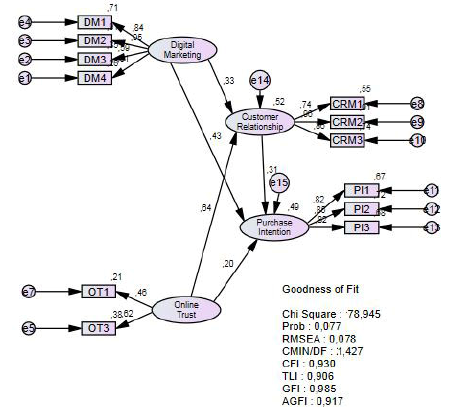
Fig. 3. Results of Structural Equation Model (SEM) using Analysis of Moments Structure